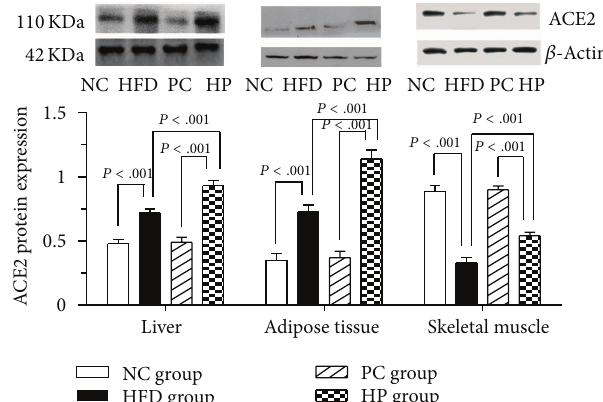
Figure 3: Effects of pioglitazone on ACE2 protein expression in insulin-sensitive tissues in rats fed a high-fat diet. In liver, adipose tissue, and skeletal muscle, ACE2 protein expression was significantly greater in the HP group compared with the HFD group. NC, normal control; HFD, high-fat diet; PC, pioglitazone control; HP, high-fat diet plus